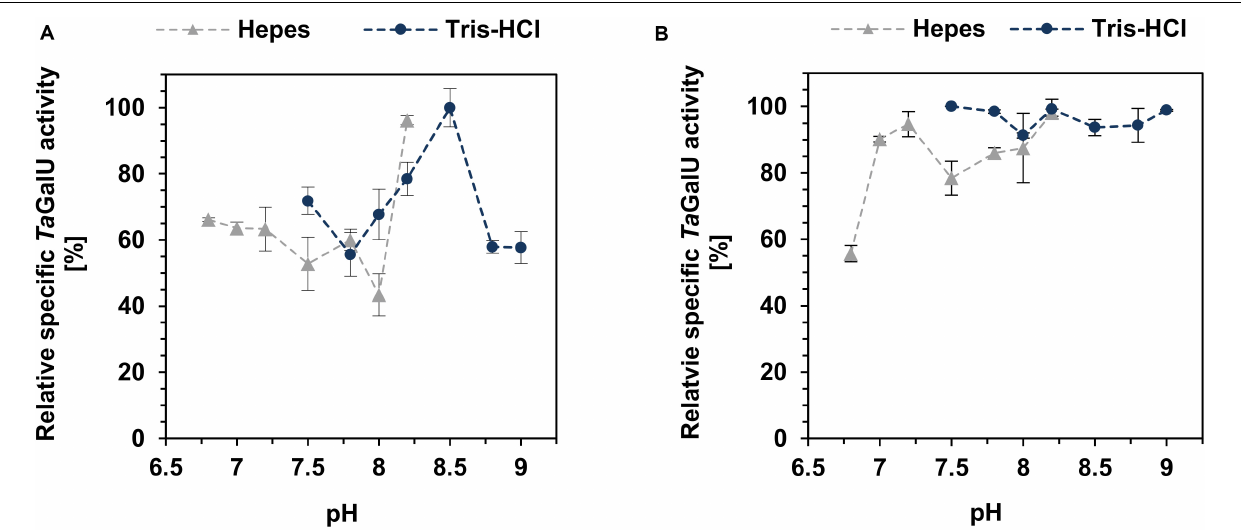
FIGURE 6 | Effect of pH on the free Ta GalU (A) and the immobilized catalyst (B) . (A) Reaction solution contained 2 mM UTP, 2 mM G1P, 3 mM MgCl 2 , 50 mM buffer, pH 6.8 – 9.0, 0.013 µ g mL − 1 free Ta GalU, 50 ◦ C in 1 mL reaction volume. 100% relative specific activity corresponds to 2876 U mg − 1 . Means with standard deviations for triplicate measurements are shown. (B) Reaction conditions are 2 mM UTP, 2 mM G1P, 3 mM MgCl 2 , 50 mM buffer, pH 6.8 – 9.0, 0.2591 µ g mL − 1 Ta GalU immobilized amino modified MCF. Reaction was carried out at 50 ◦ C in 3 mL reaction volume. Means with standard deviations are shown from triplicate reactions. 100% relative specific activity corresponds to 1568 U mg − 1 .